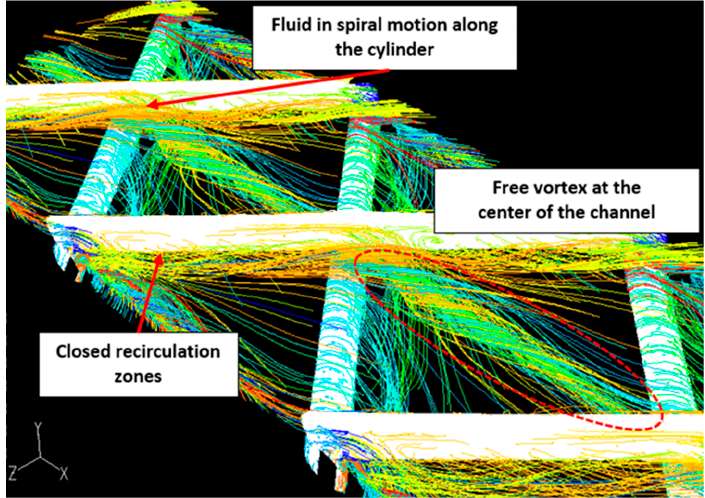
Figure 2. An instantaneous view of fluid-particle pathlines showing the major qualitative characteristics of the flow; h / D = 0.05, Re = 193.